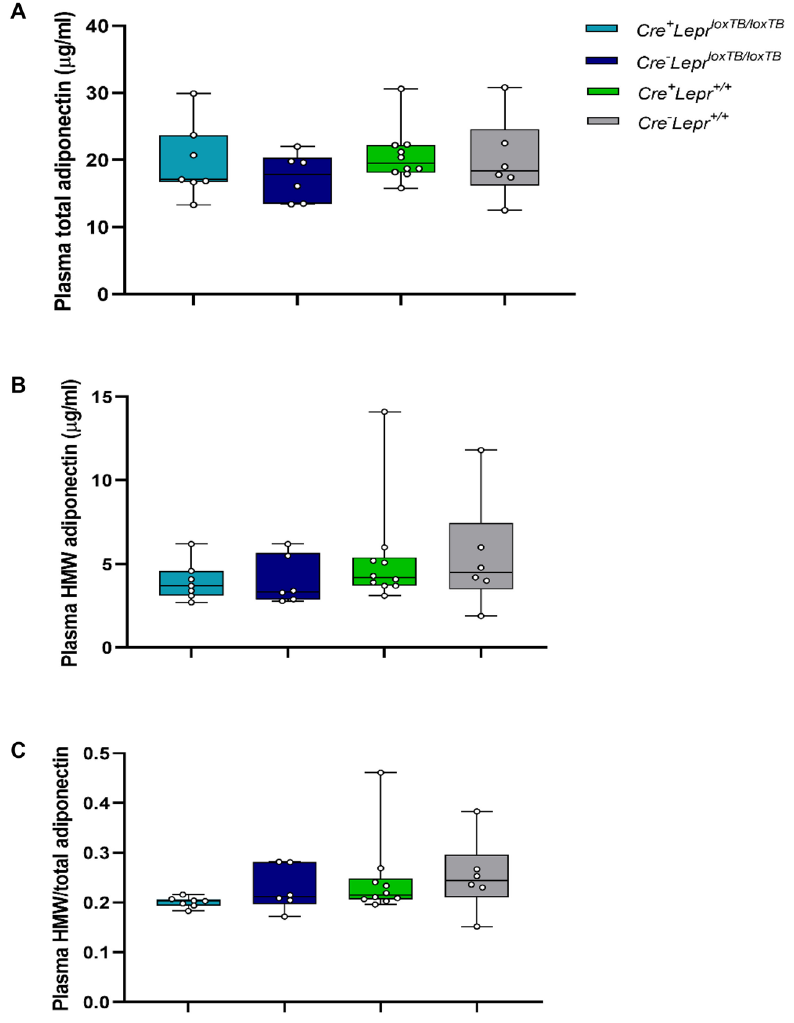
Figure 6. Concentration of total adiponectin ( A ), concentration of high molecular weight (HMW) adiponectin ( B ), and ratio of HMW to total adiponectin ( C ) in plasma obtained from male mice in the Lepr reconstitution study after a 16 h fast. In ( A – C ), n = 7 for Cre + Lepr loxTB/loxTB , n = 6 for Cre − Lepr loxTB/loxTB , n = 10 for Cre + Lepr + / + , and n = 6 for Cre − Lepr + / + . Performed one-way ANOVA with Tukey’s post-hoc